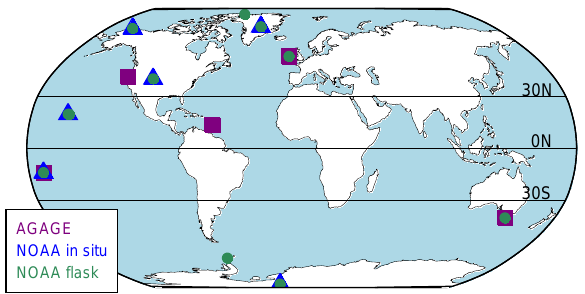
Fig. 1. Locations of AGAGE and NOAA CFC and CH 3 CCl 3 mea- surements. Purple squares show locations of AGAGE (in situ) sta- tions, blue triangles show the locations of NOAA in situ monitoring sites and green dots show NOAA flask sampling locations. Also shown are the boundaries of the chemical transport model